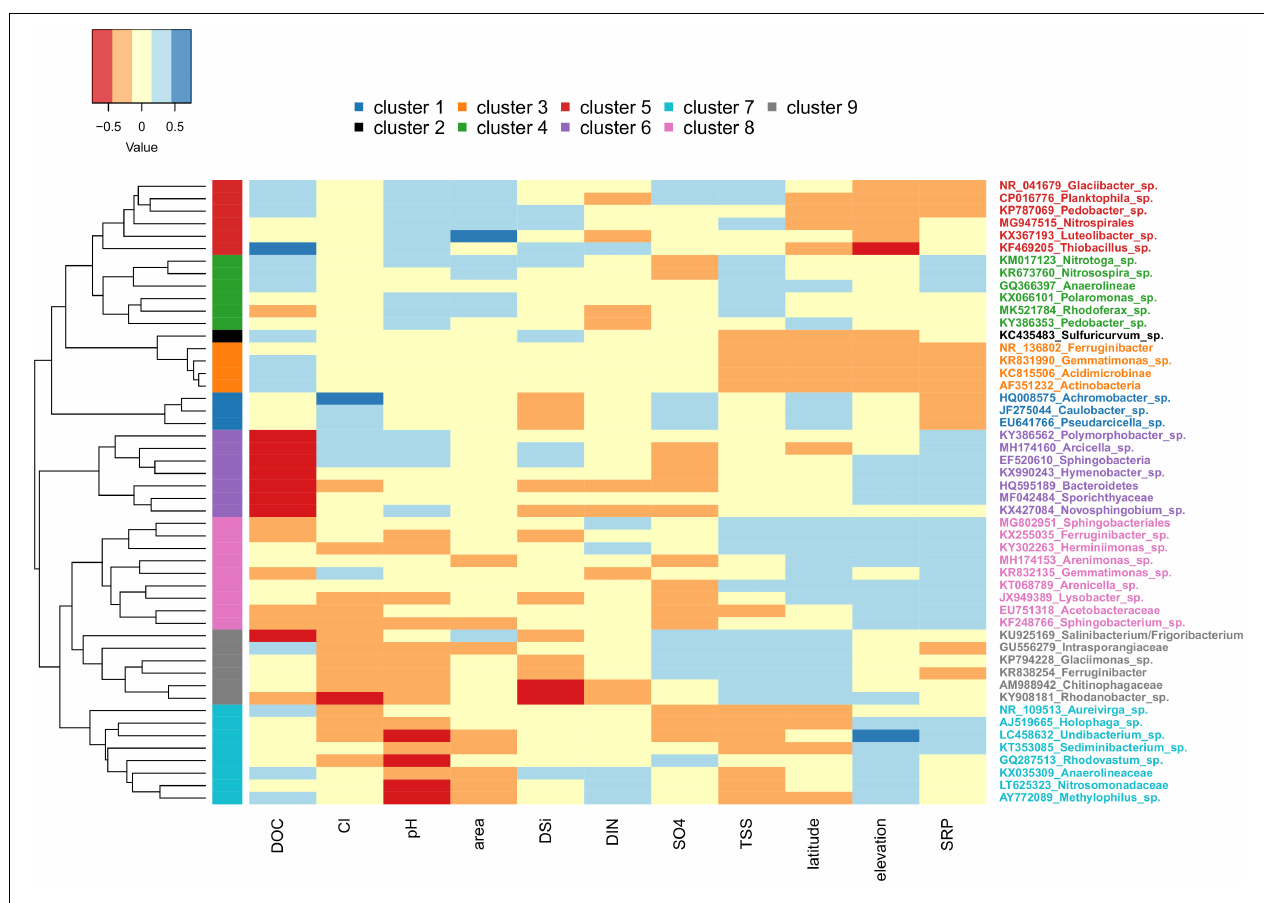
FIGURE 7 | Heatmap showing the relationship between environmental variables (only those with variance inflation factors less than or equal to 5 included) and the top 50 OTUs. Sites with missing metadata were excluded (i.e., Foxfonna and Midtre Lovénbreen, see Tables 1 , 2 ). Cool colors indicate high Pearson correlation coefficient values, and warm colors indicate low values. The row side bar indicates the nine significant OTU